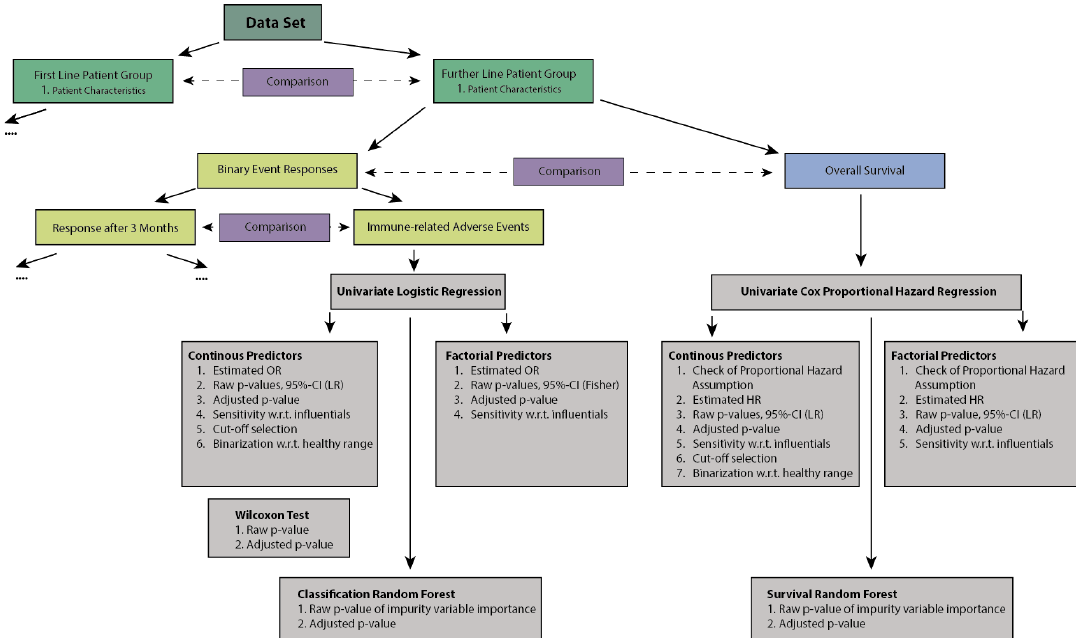
Figure 1. Schematic of statistical methods used.